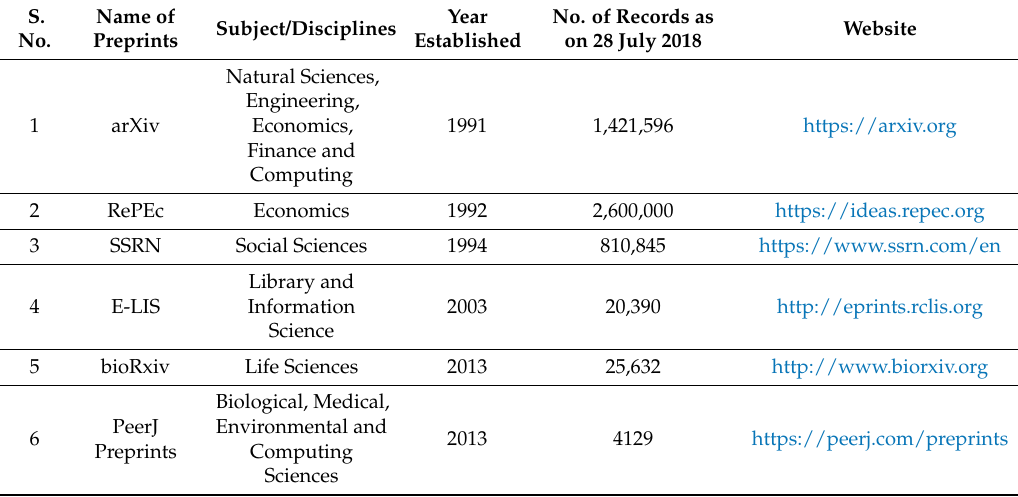
Table 1. Growth of preprint repositories, 1991–2018 1